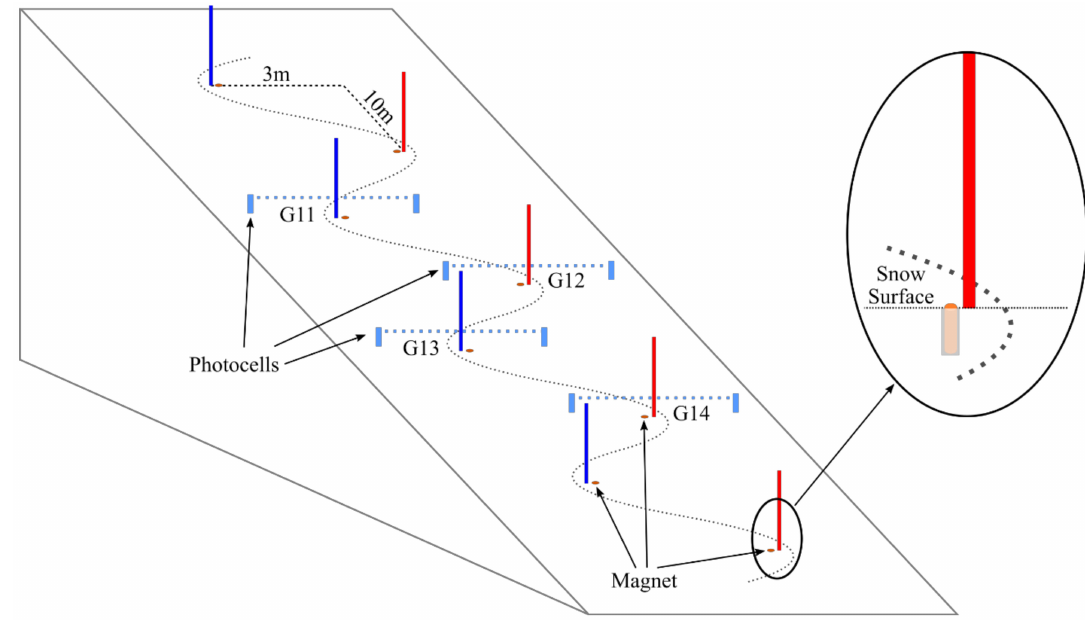
Figure 2. Setup of the slalom course. For better visualization, only gates 9 to 16 are shown. The photocells of the reference system were placed 0.1 m before gates 11–14. The bar magnets were buried completely into the snow surface to avoid any risk of